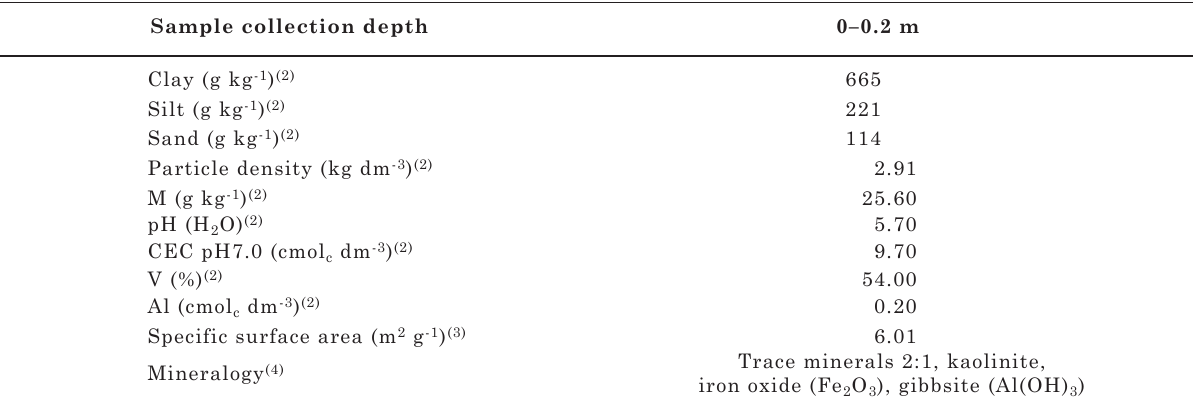
table 1. Physical and chemical characterization (1) of samples of eutroferric red oxisol (lVef) under annual no-till cropping